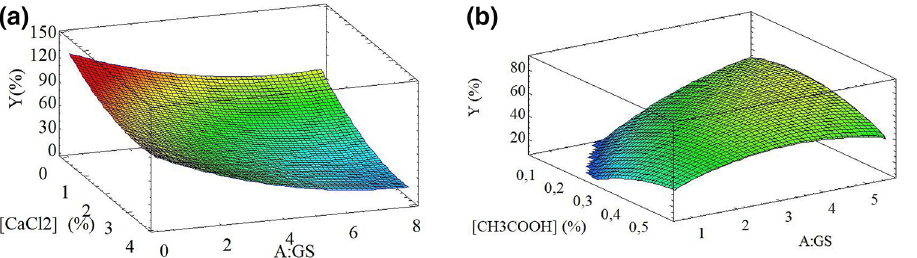
Figure 1. Responses surfaces plots for (%Y) resulted from ( a ) EG and ( b ) IG.